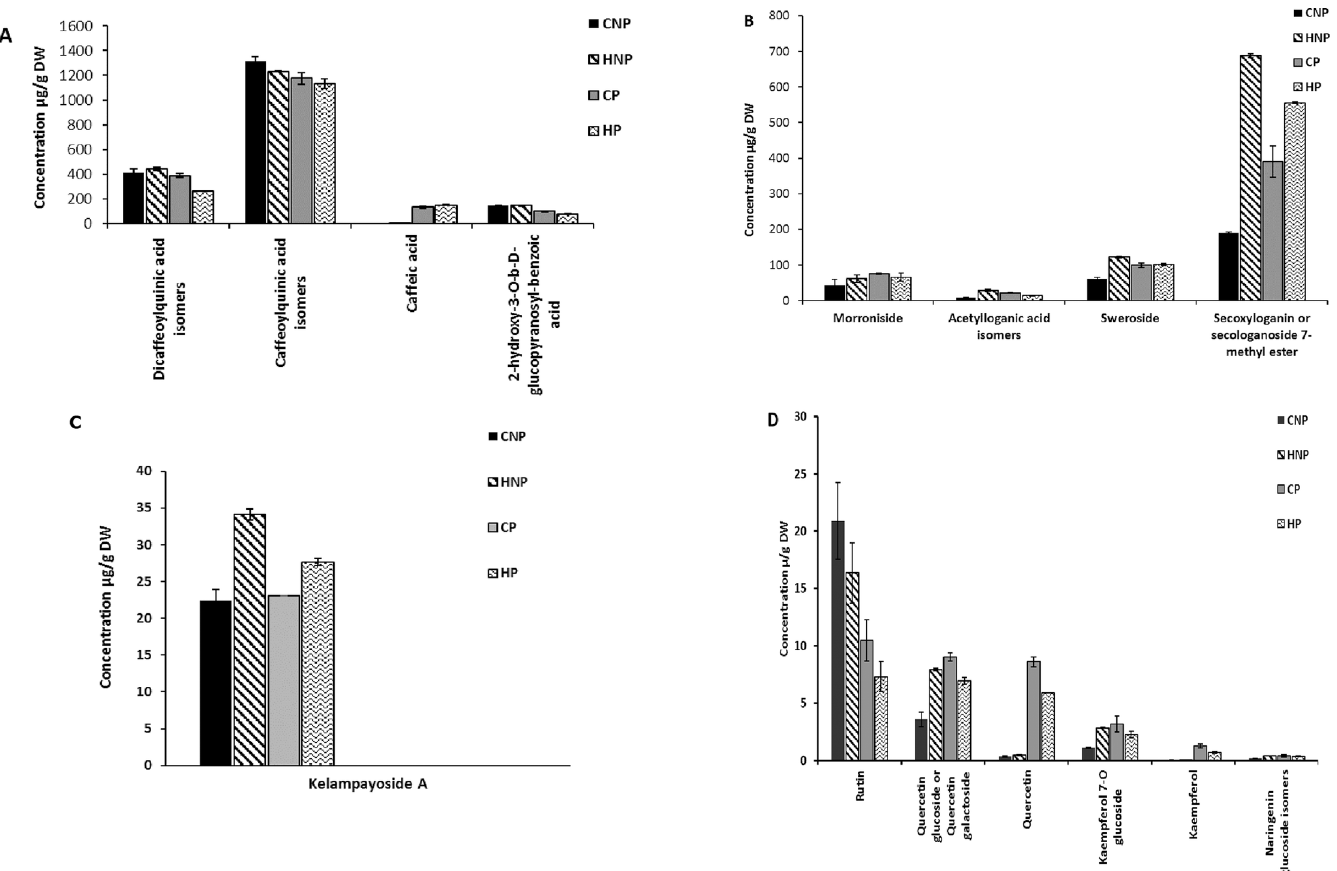
Fig 3. Phenolic compounds content of A: Phenolic acids, B: IGs, C: Kelampayoside A, D: Flavonoids, of Strychnos cocculoides pulp. Data are expressed as μ g/ g of dry weight ± standard deviation with n =